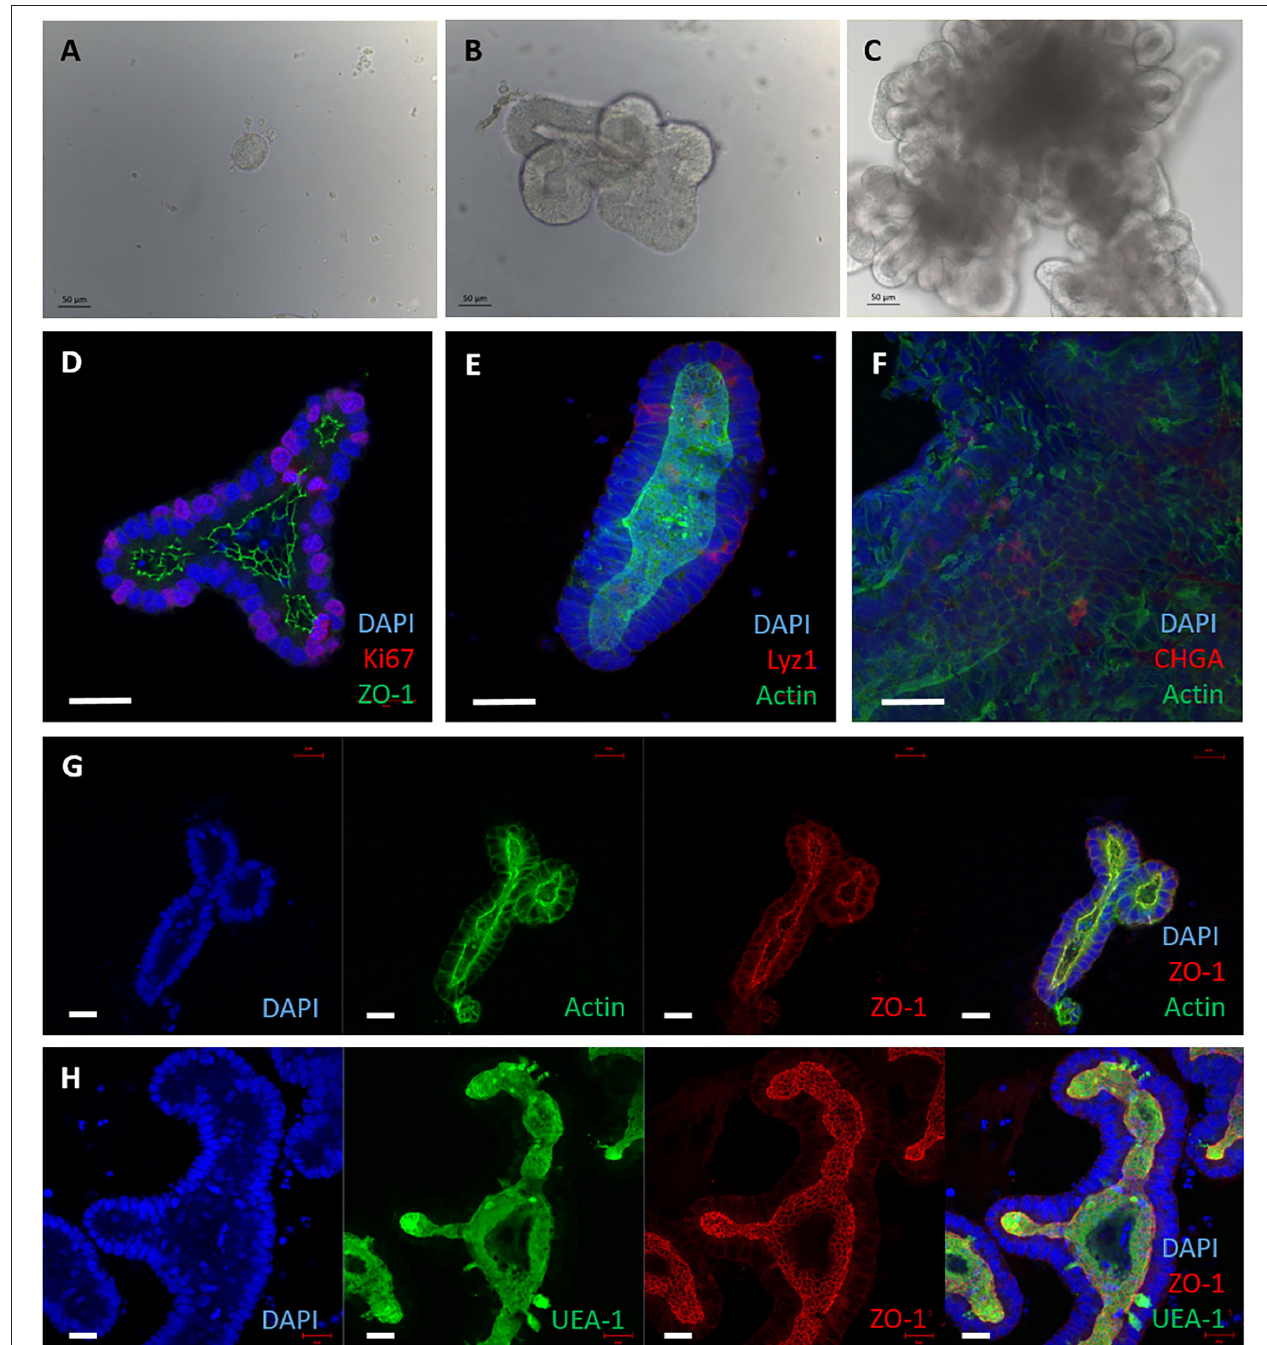
FIGURE 1 | 3D enteroids cultivated from bovine intestinal tissue. Representative images showing crypts isolated from bovine ileal tissue and maintained in a Matrigel dome with IntestiCult medium, from 5 independent animals. (A–C) Brightfield images of 3D enteroids cultured for 24h (A) , 3 days (B) and 7 days (C) demonstrating that they bud and proliferate over time. By 7 days the enteroid lumen fills with debris from cells sloughed off and are ready to be passaged. (D–H) Confocal images of 3D bovine enteroids stained for epithelial cell fate markers. (D) Nuclei (DAPI, blue), tight junctions (ZO-1, green) and proliferative cells (Ki-67, red). (E) Nuclei (DAPI, blue), actin (Phalloidin, green) and Paneth cells (lysozyme, red). (F) Nuclei (DAPI, blue), F-actin (Phalloidin, green) and enteroendocrine cells (chromogranin A, red). (G) Split panel of enteroids stained for nuclei (DAPI, blue), F-actin (Phalloidin, green), and tight junctions between cells (ZO-1, red). (H) Split panel of enteroids stained for nuclei (DAPI, blue), glycolipids (UEA-1, green) and tight junctions (ZO-1, red). Scale bar = 50 µ m.